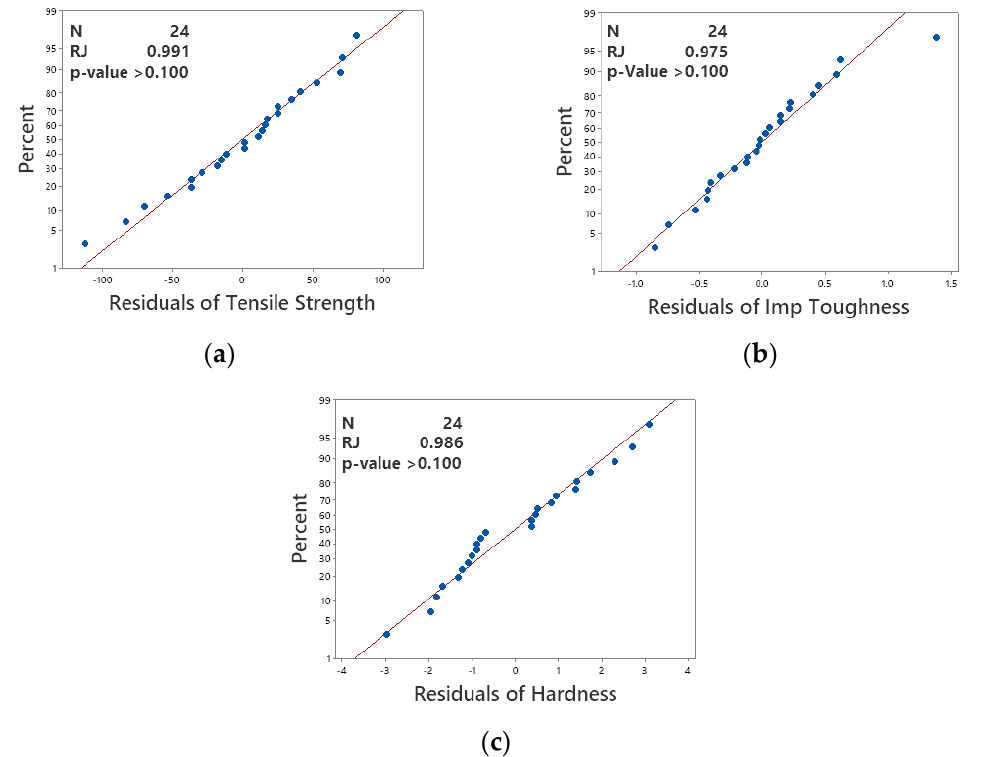
Figure 7. Normal probability plot of residuals for ( a ) tensile strength, ( b ) impact toughness, and ( c ) hardness data. p -values > 0.05 indicate that residuals are normally distributed.